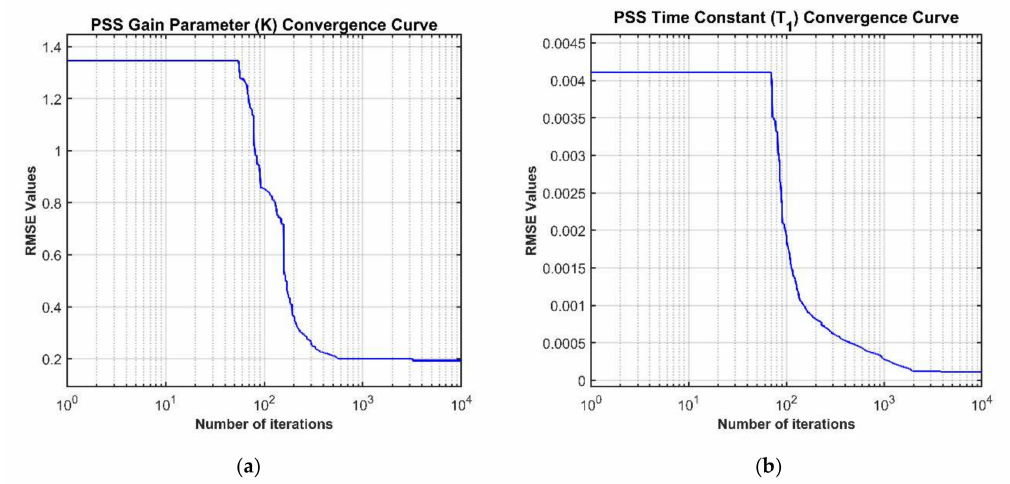
Figure 9. RMSE values convergence curves for the PSS key parameters of the second network test datasets; ( a ) PSS gain parameter ( K ) and ( b ) PSS time constant parameter ( T 1 ).